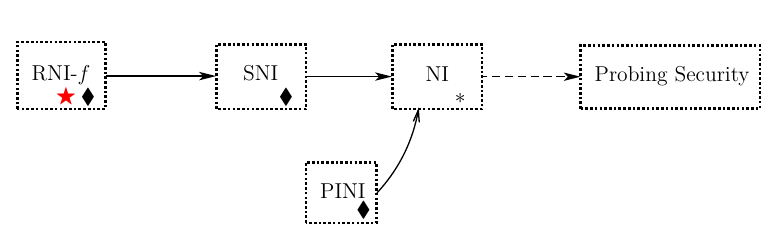
Figure 7: Relations of different security notions